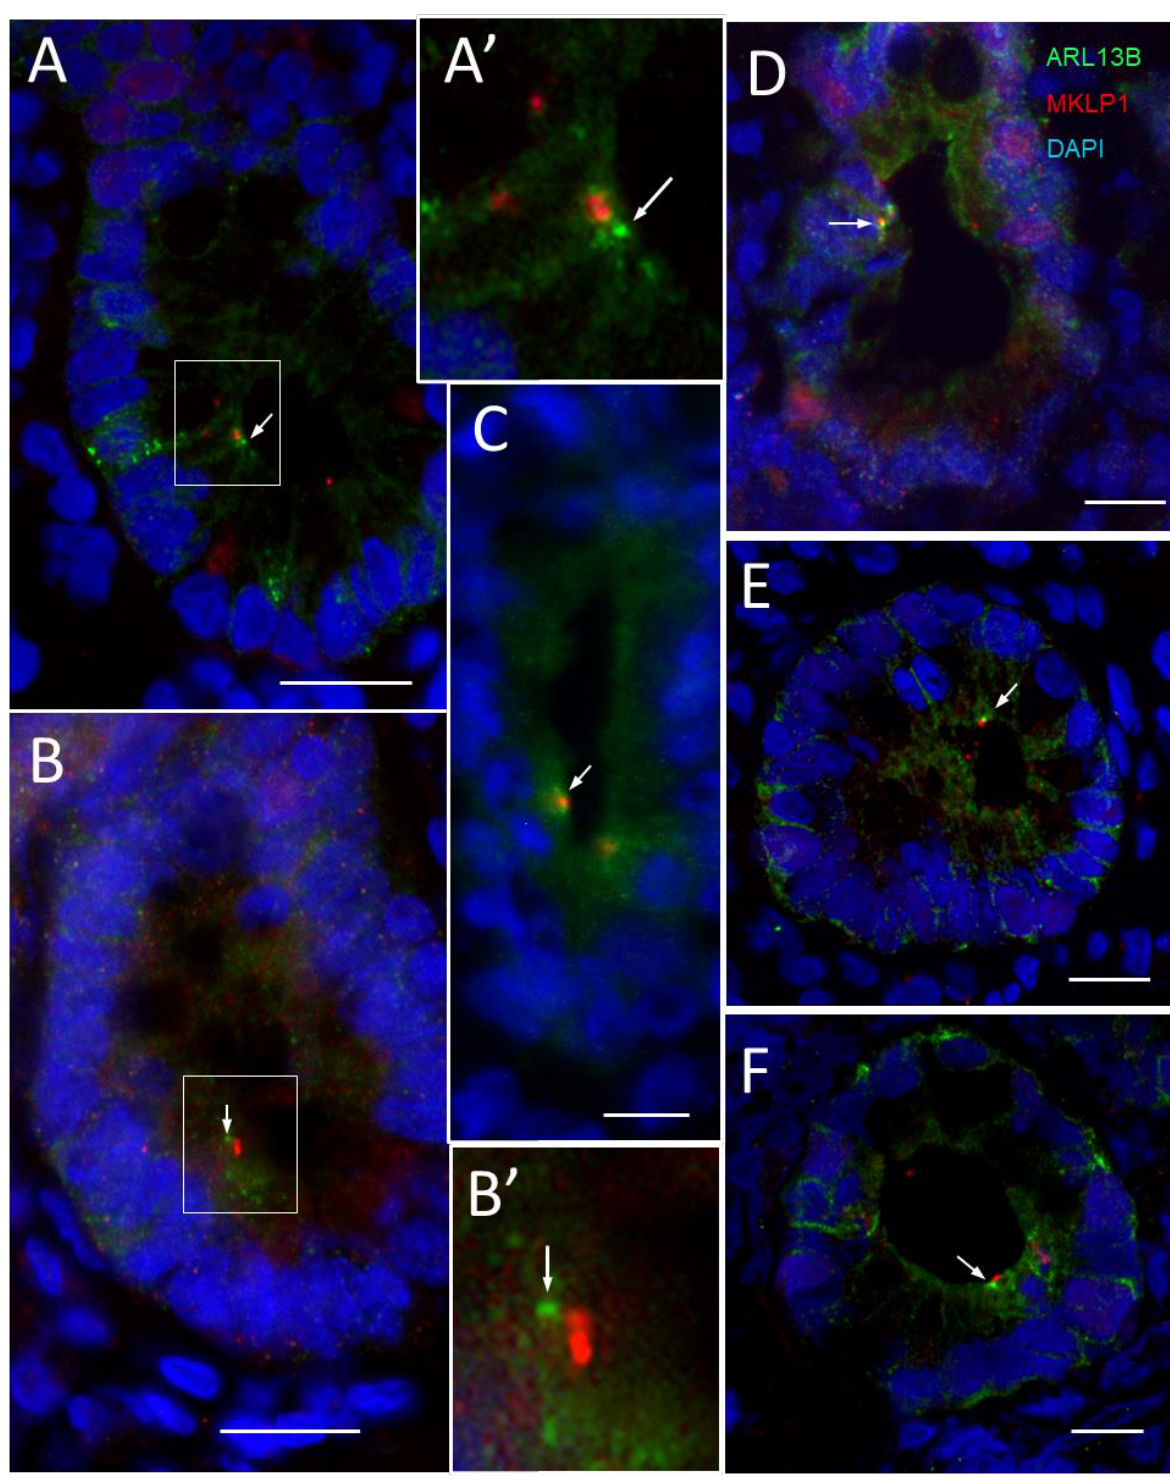
Figure 7. Primary cilia and midbody remnants in the lower third of the crypts of the human small intestine. ( A – E ) Representative immunodetection of primary cilia using anti-ARL13b 90413h antibody (green staining, arrow) and of midbody remnants using an anti-MKLP1 antibody (red staining) in various crypts. In most cases of positive crypts, the 90413h antibody stained one predominant dot ( A – F ) that was localized adjacent to a positive MKLP1-labeled dot. ( A ’ , B ’ ) Higher magnification of the section delimited by the squares in ( A , B ) showing adjacent dots stained by ARL13B and MKLP1. Nuclei were stained with DAPI (blue staining). Scale bars are equal to 10 µm.